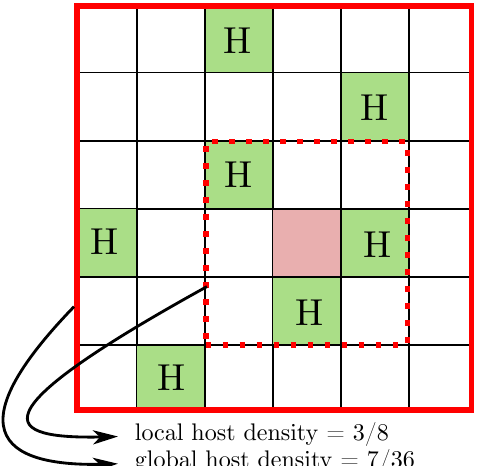
Figure SI.2. Local and global host densities influence the probability of establishment in the focus cell (pink filled square). The global density corresponds to the host density in the whole 36-cell landscape. The local density corresponds to the density in the eight cells vicinity around the focus